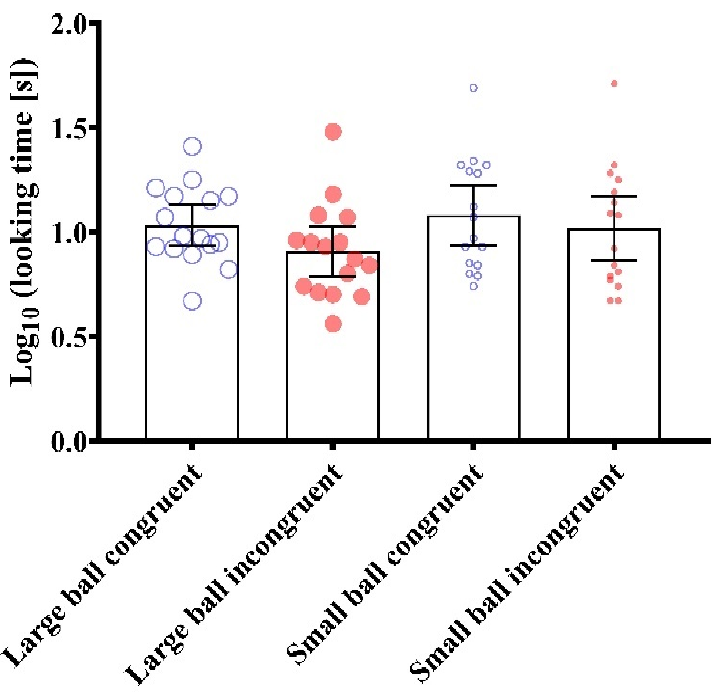
Figure 3. Looking time for small and large ball congruent and incongruent test events. Data are presented as grouped dot plots and mean and 95% confidence intervals. AU = arbitrary units.